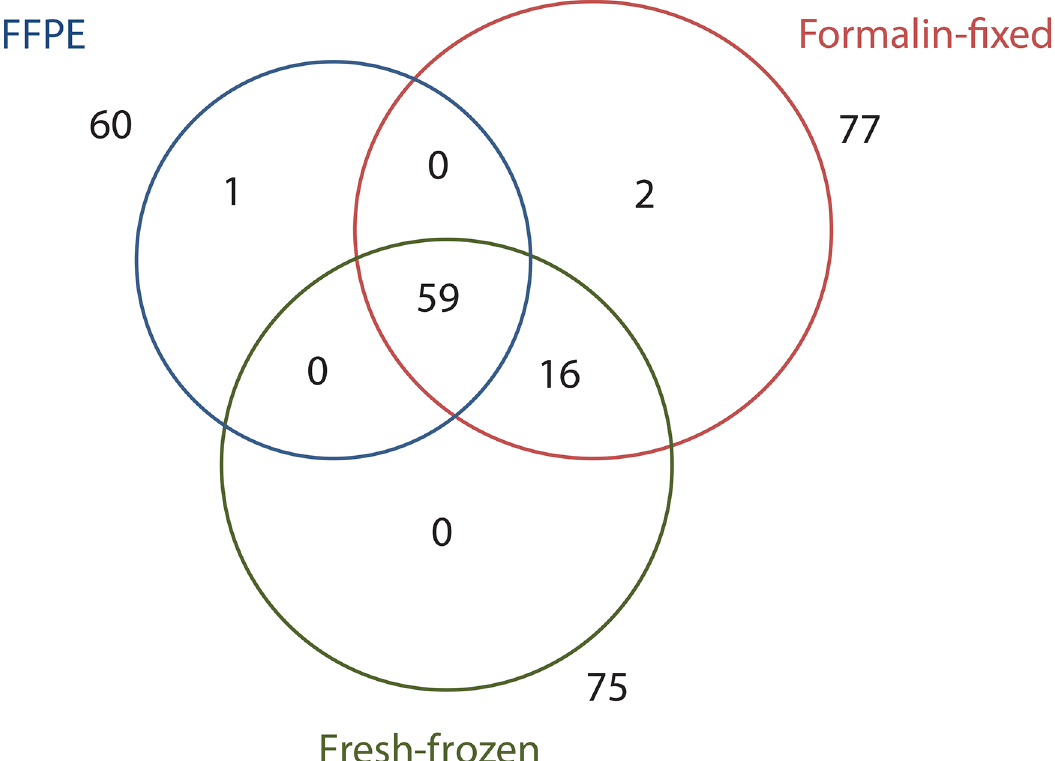
Fig 2. Venn diagram showing numbers of identified compounds detected in extracts from fresh-frozen, formalin-fixed and FFPE specimens of mouse kidney (samples were fixed with formalin for 24h).